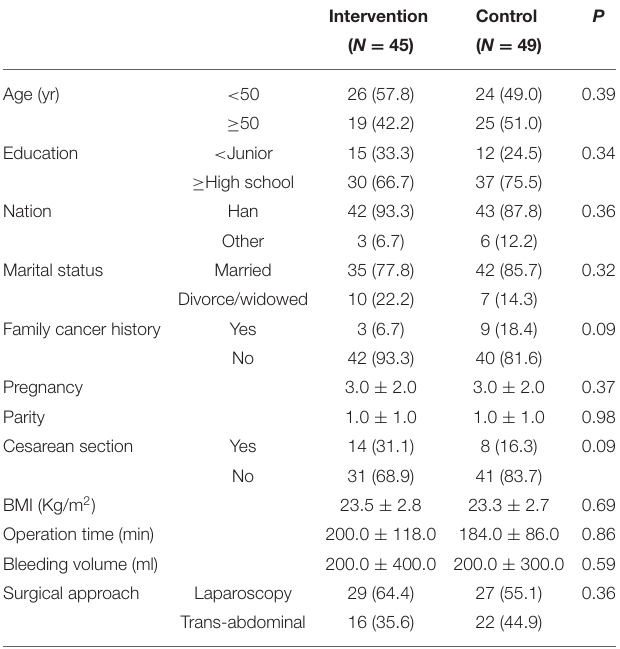
TABLE 1 | Baseline and clinical characteristics between the two groups. Intervention Control higher than that in the control group by the 28 th d (15.7